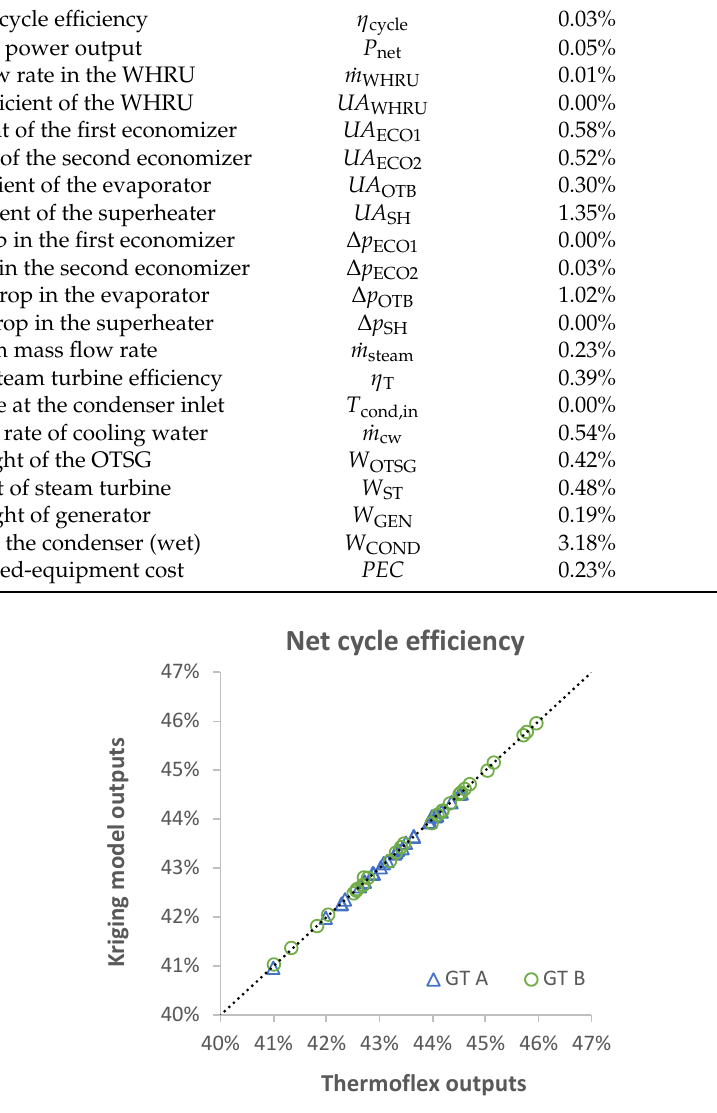
Figure A1. Parity plot of the net cycle efficiency for Kriging model validation.